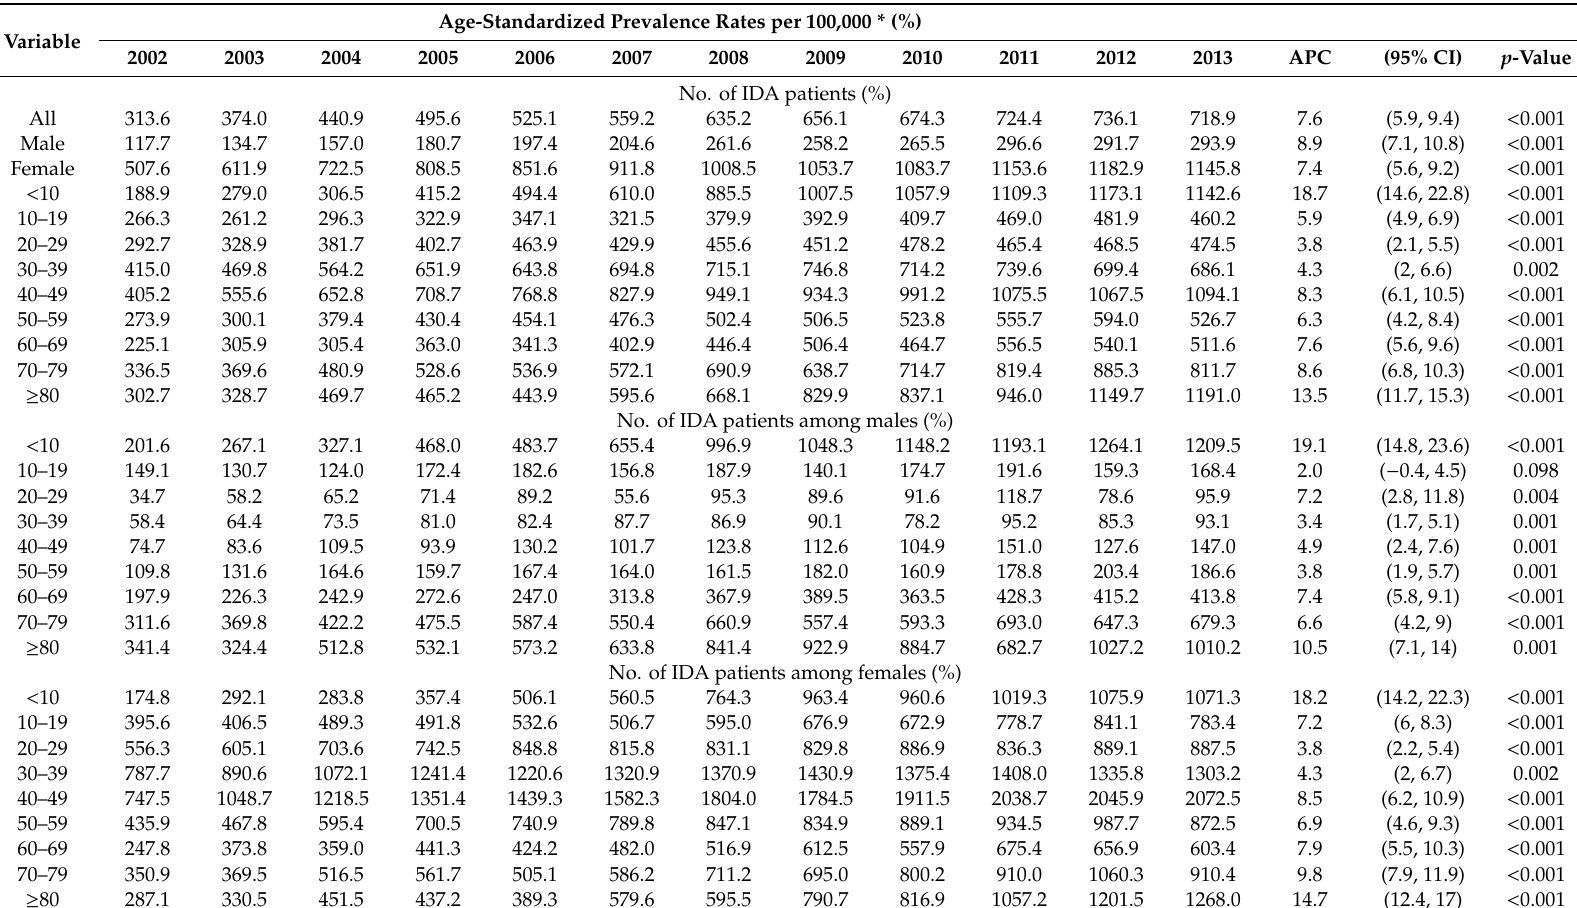
Table 2. Prevalence of iron deficiency anemia in Korea,